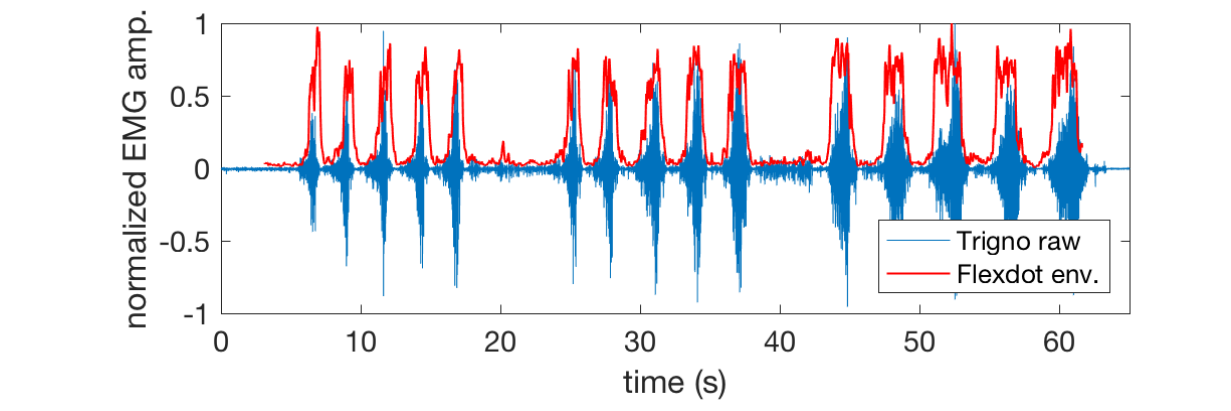
Figure 7. EMG acquired by the Flexdot sensors (red) accurately captured the envelope of the raw EMG activity that was measured by high-end commercial EMG sensors (blue). EMG: